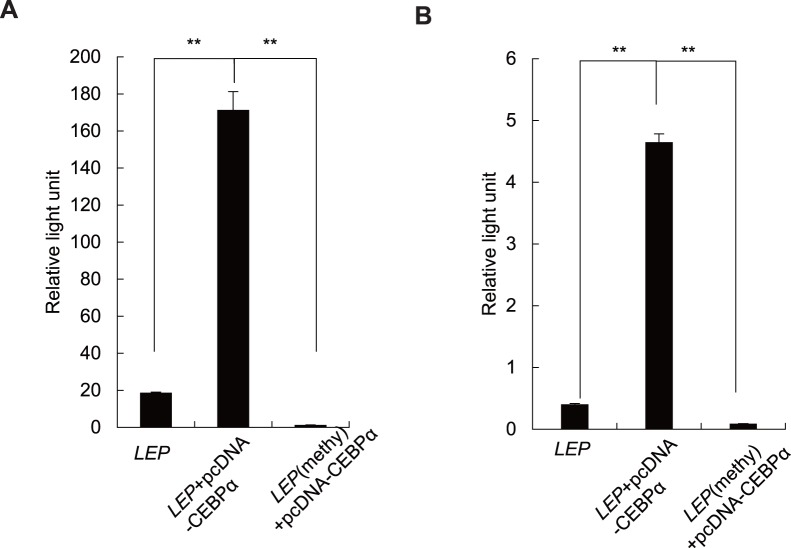
Luciferase reporter analysis of the transfection in cell lines.(A) Luciferase activity of LEP-pGL3 and in vitro methylated LEP (methy)-pGL3 constructs in JEG-3 cells; (B) Luciferase activity of LEP-pGL3 and in vitro methylated LEP (methy)-pGL3 constructs in HEK293 cells.